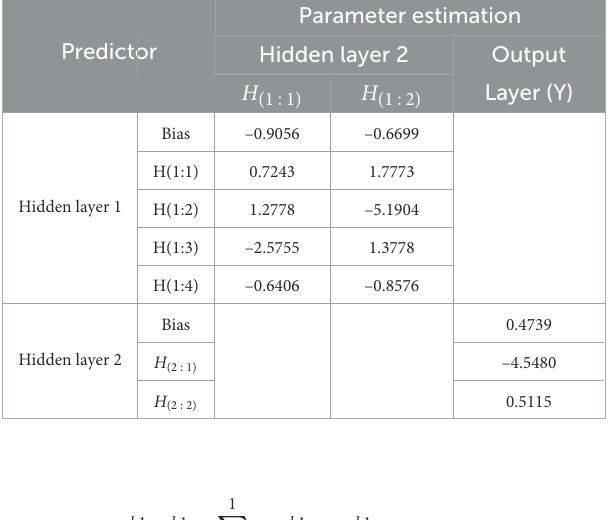
TABLE 12 Parameter estimation of FFNN model from hidden layer to output layer.